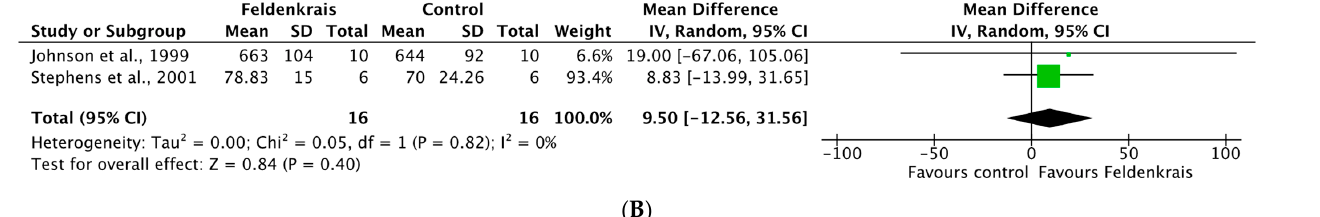
Figure 3. ( A ) Meta-analysis for the Function dimension of the MSSE scale in subjects with multiple sclerosis. ( B ) Meta-analysis for the Control dimension of the MSSE scale in subjects with multiple sclerosis. (Johnson et al. [22], Stephens et al. [26]).